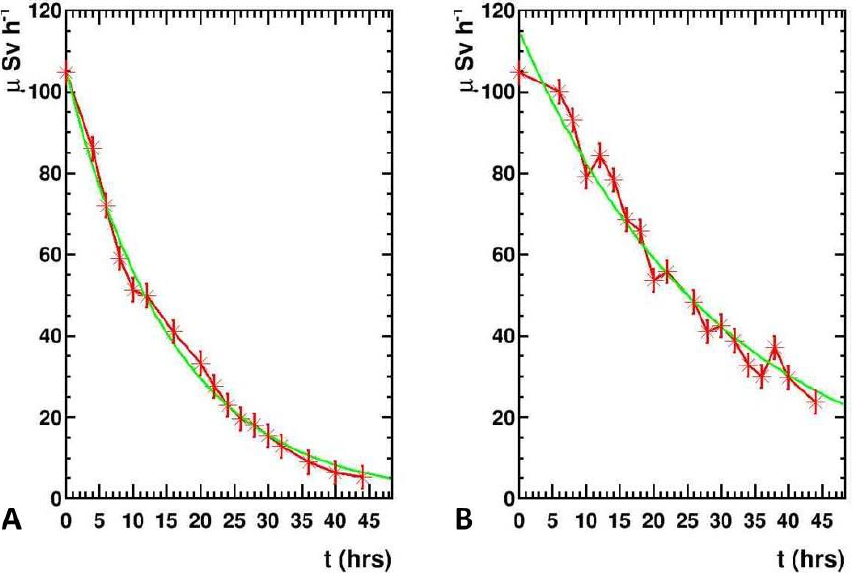
Figure 3. Effective 131 I half-life regression curves for two patients, to whom the same initial activity (3700 MBq) was administered. ( A ) refers to a patient without 131 I extra-thyroidal uptake at WBS and ( B ) refers to a patient with 131 I extra-thyroidal uptake at WBS. The best fits to the experimental data were obtained using a mono-exponential ( A ) and a bi-exponential curve ( B